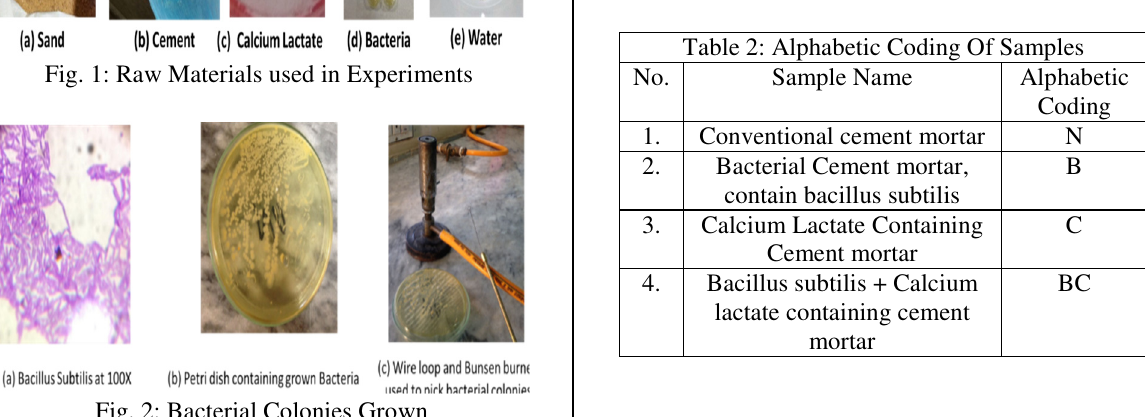
Fig. 3: Process Flow Table 2: Alphabetic Coding Of